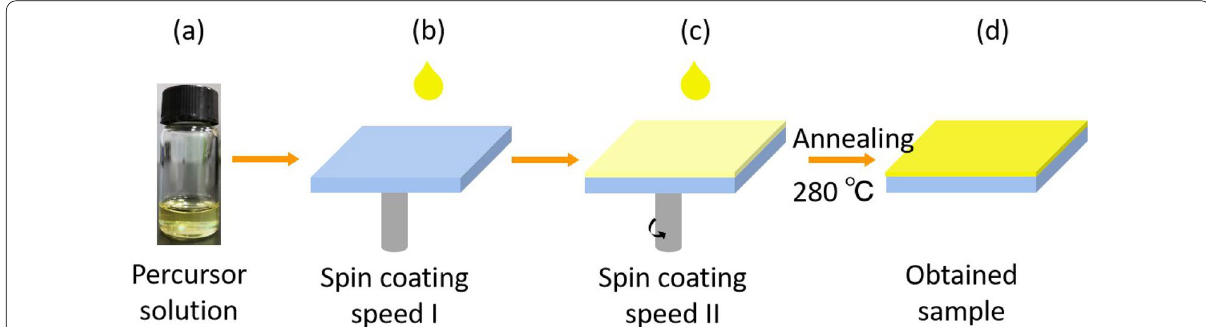
Fig. 1 Solvent engineering procedure for preparing the CABB/ITO/glass